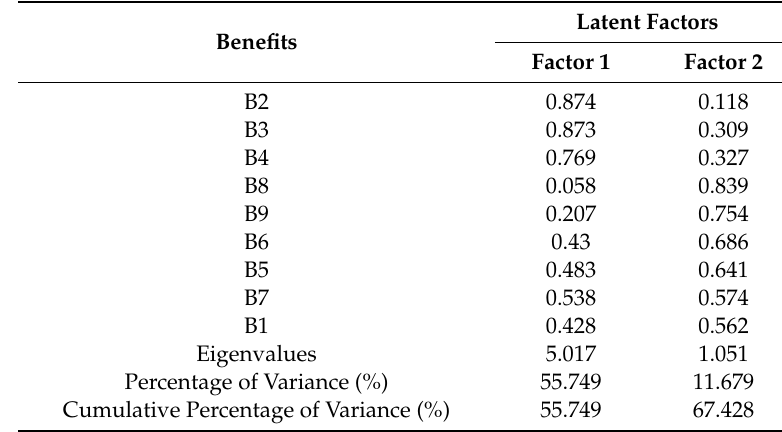
Table 8. Factor analysis on benefit variables.